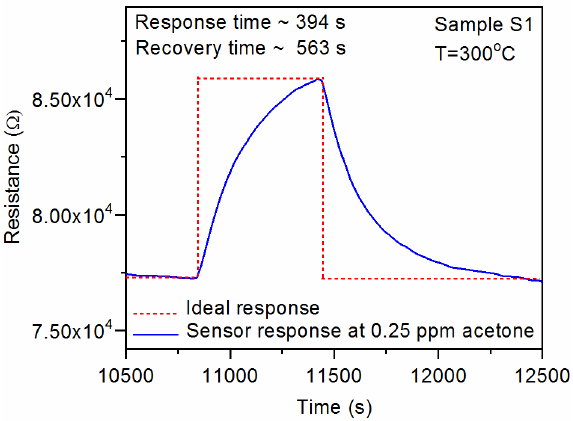
Figure 7. Sensor response as a function of acetone concentration at 300 °C and 50% RH for pure CuO (sample S0) and CuO:Ga films deposited with 4% at. (sample S1), 8% at. (sample S2), and 16% at. (sample S3) of gallium concentration. Sensors 2020 , 20 , x FOR PEER REVIEW 13 of 18